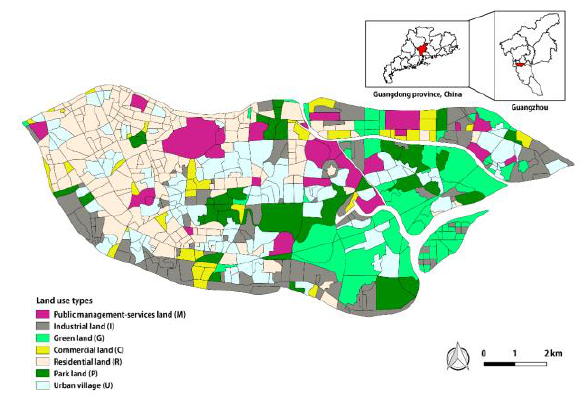
Figure 1. Urban land-use data obtained from manual interpretation at the land-parcel level for the case-study area: Haizhu district, Guangzhou, Guangdong Province.